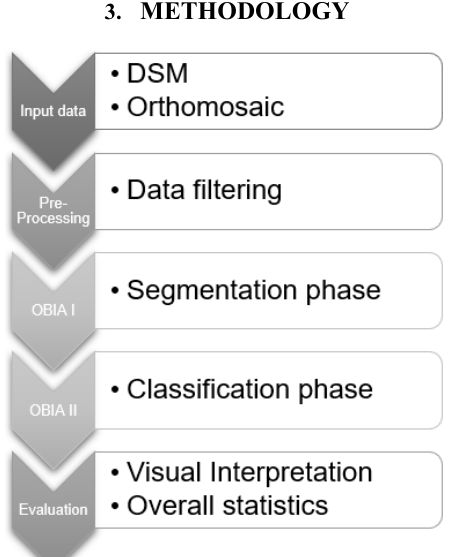
Figure 4. Flowchart of the proposed